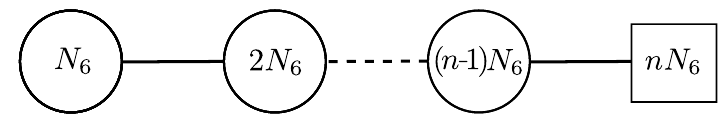
Figure 6 . Completed quiver associated to the non-Abelian T-dual of AdS 5 (cid:2) S 5 . Each line represents a hypermultiplet of N = 2